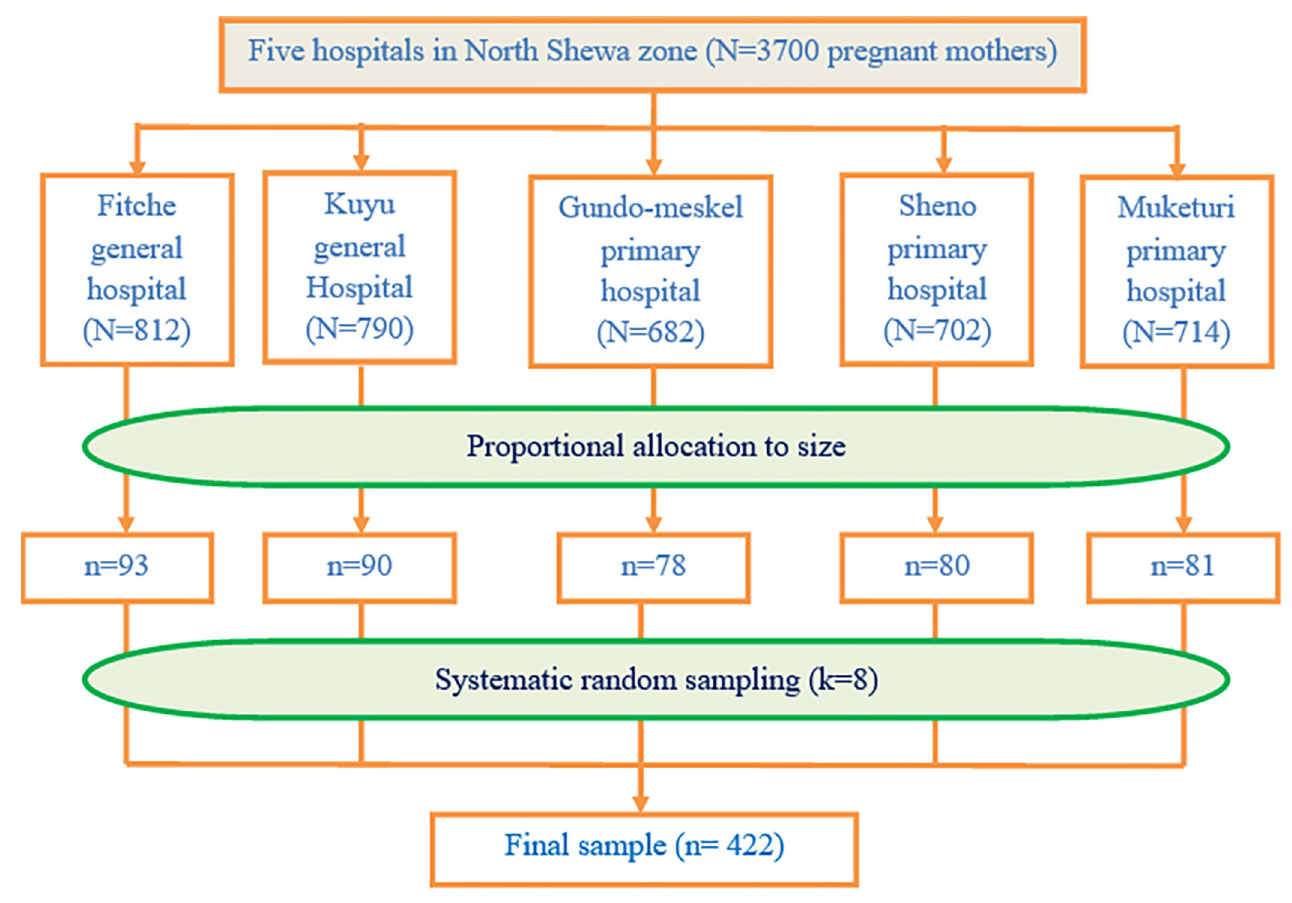
Fig 1. Schematic presentation of sampling